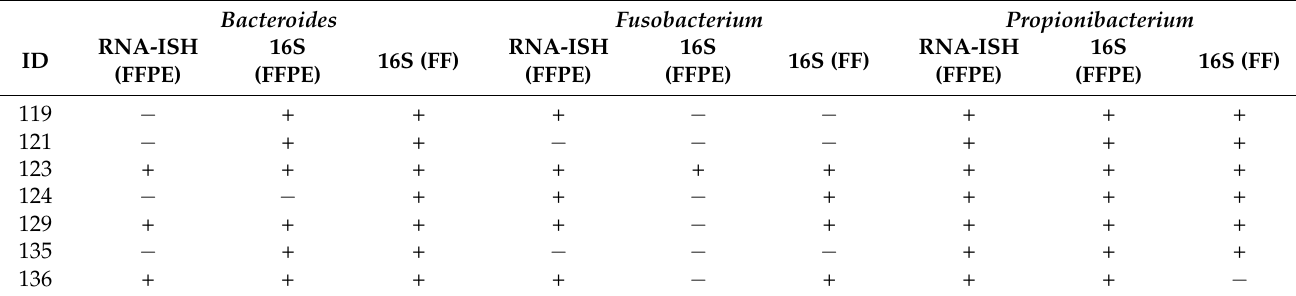
Table 2. Presence or absence (+/ − ) of bacterial genera characterized by RNA-ISH and 16S rRNA sequencing for each of the sample pairs tested evaluable for RNA-ISH.